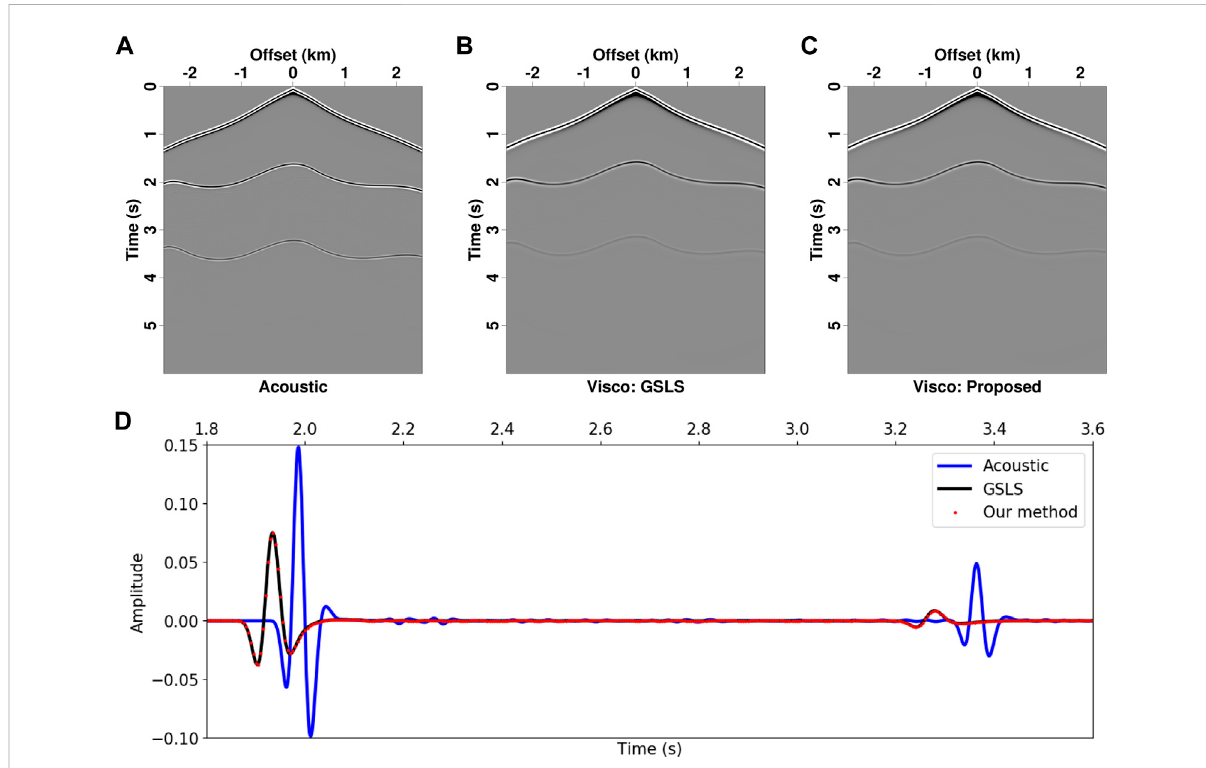
FIGURE 8 Common-shotgatherssimulatedwithatopabsorptionboundaryforthethree-layermodel. (A) Acousticmodeling, (B) viscoacousticmodeling using the GSLS method, (C) viscoacoustic modeling using the proposed method, and (D) single-trace comparison at the offset of − 2.3 km. The amplitudes of panel (D) are normalized by the maximum value of direct